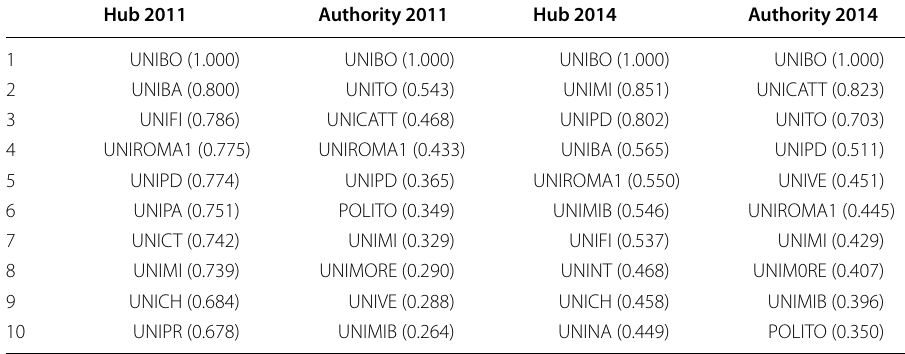
Table 3 Top 10 hub and authority scores at university level for the 2011–12 and 2014–15